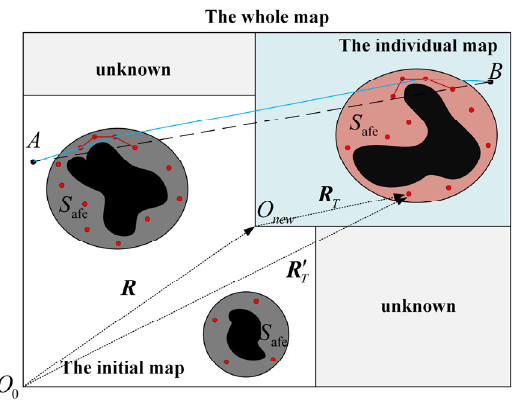
Figure 14. Schematic of the map extension.